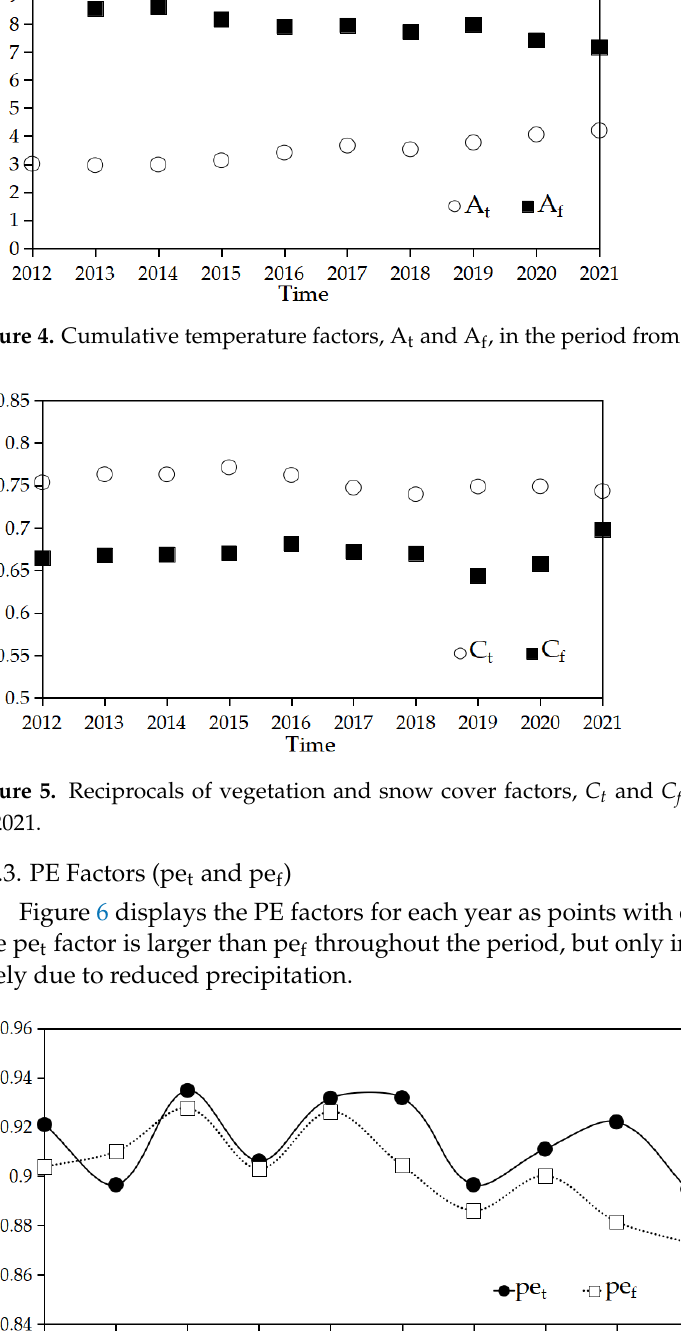
Figure 6. Temporal changes in PE factors (pe t and pe f ) for the period from 2012 to 2021.